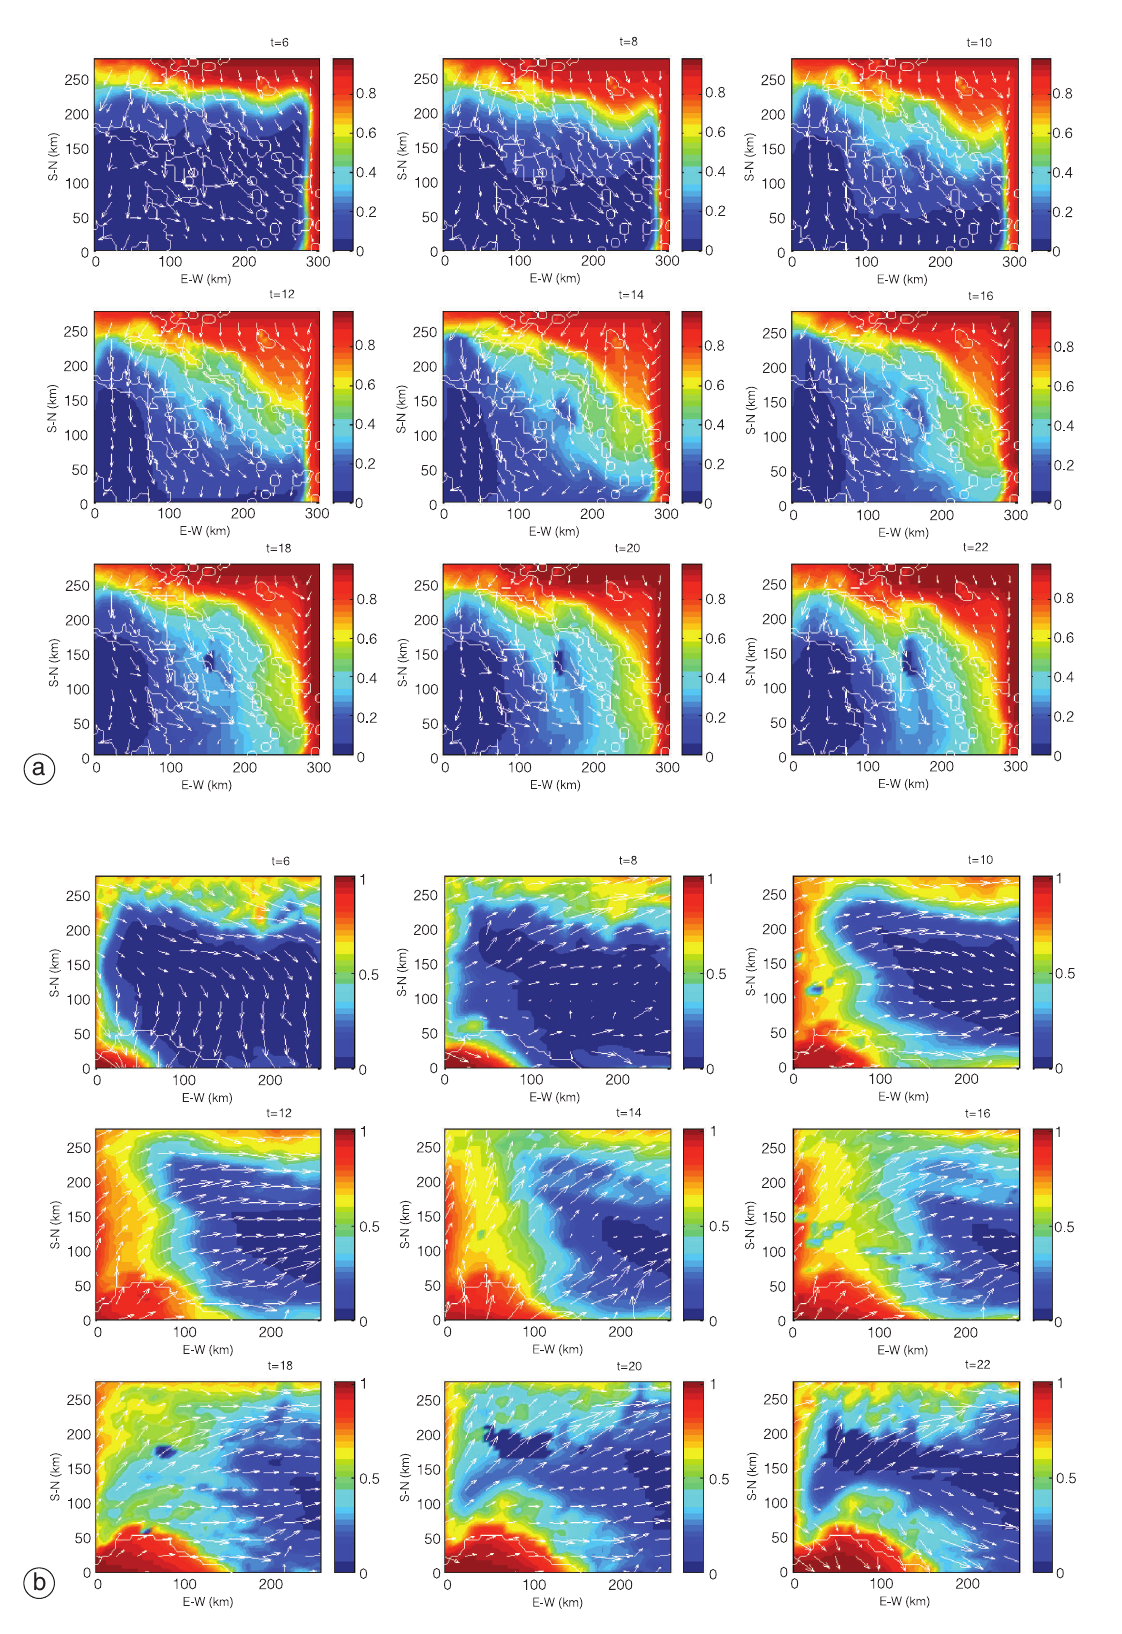
a Fig. 1a,b. Evolution of S 1O3 O3 for the domain of: a) Athens; b) Milan.